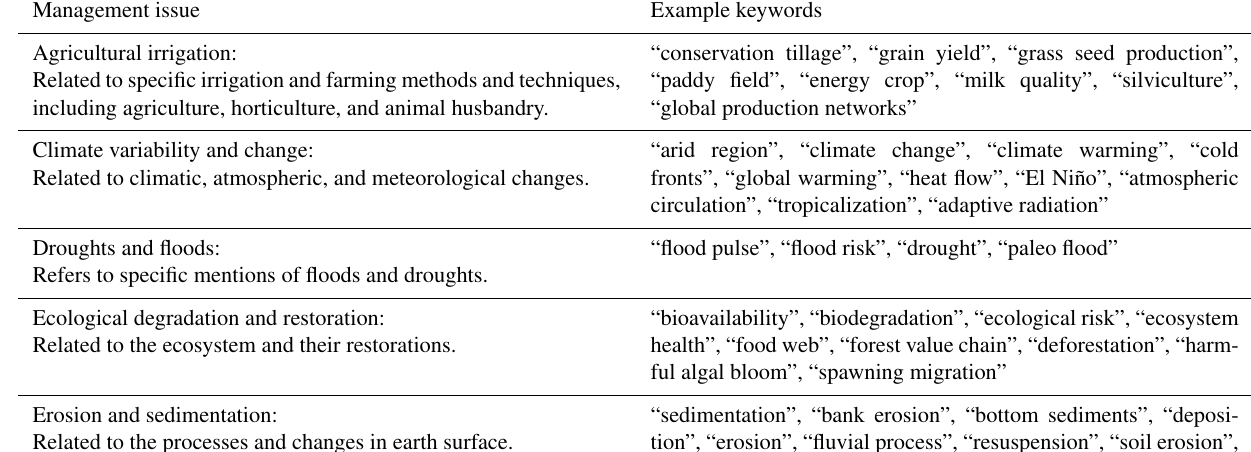
Table B1. Summary of identified management issues and example keywords in each issue